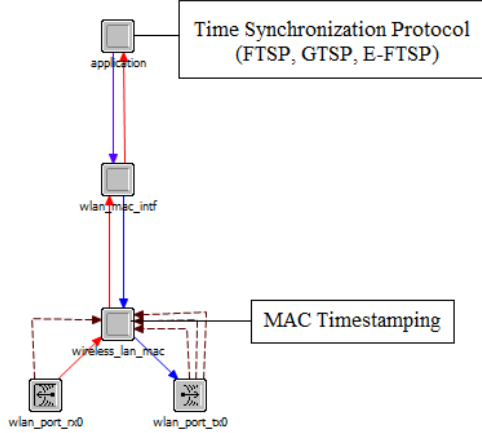
Figure 1. Node model in OPNET used to implement protocols in the